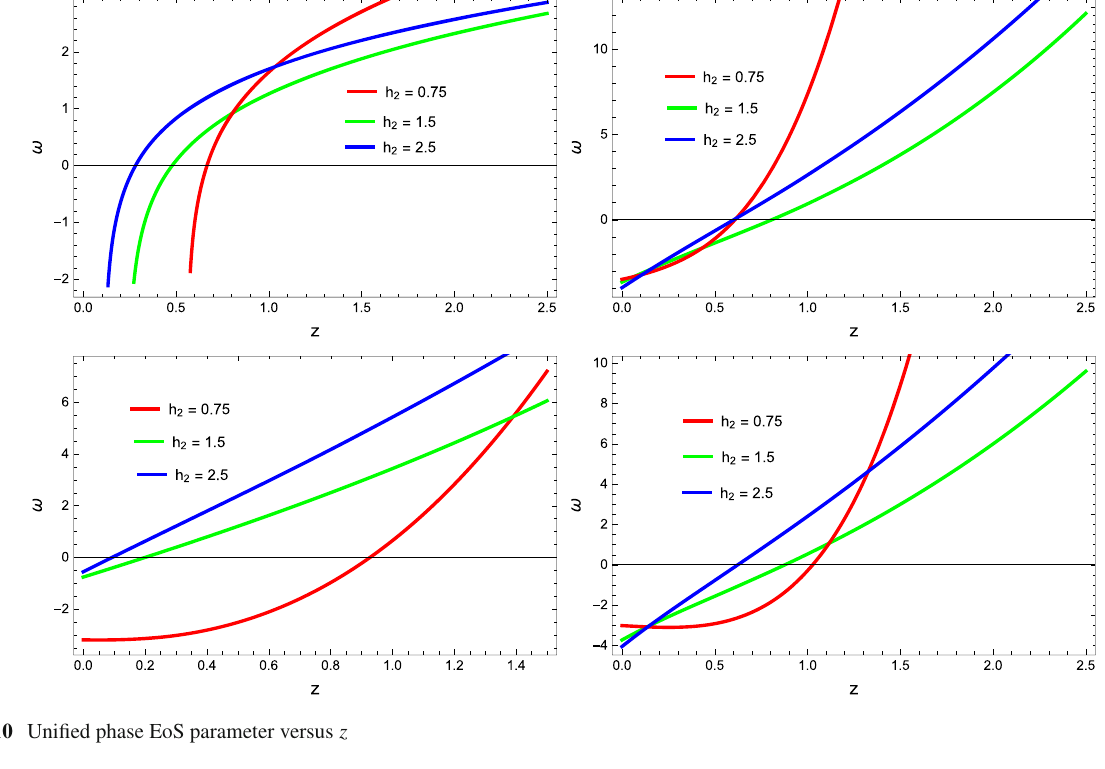
Fig. 10 Unified phase EoS parameter versus z